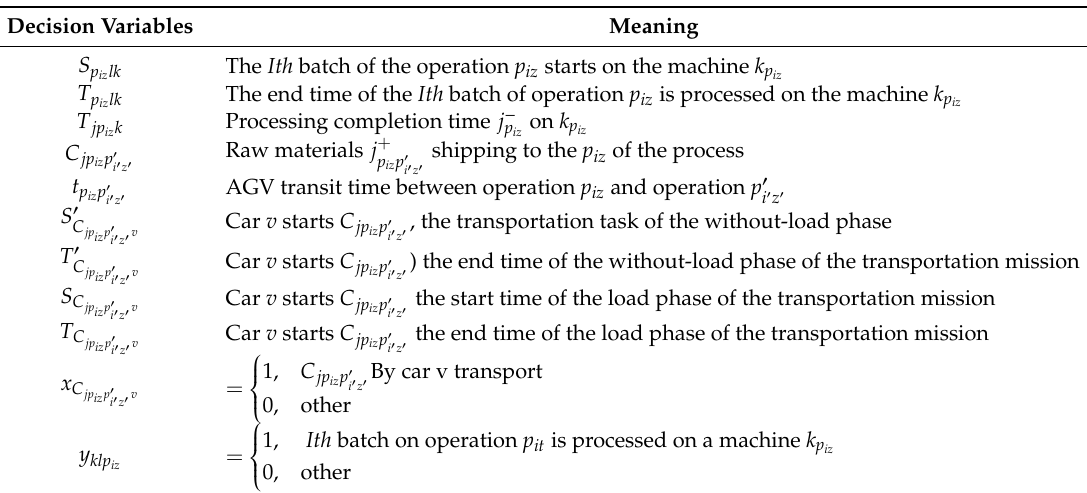
Table 2. Variable